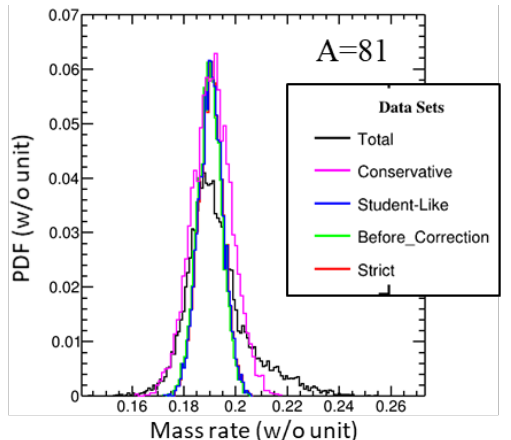
Fig. 16. PDFs of evaluated mass rates before absolute normalization for an acceptable